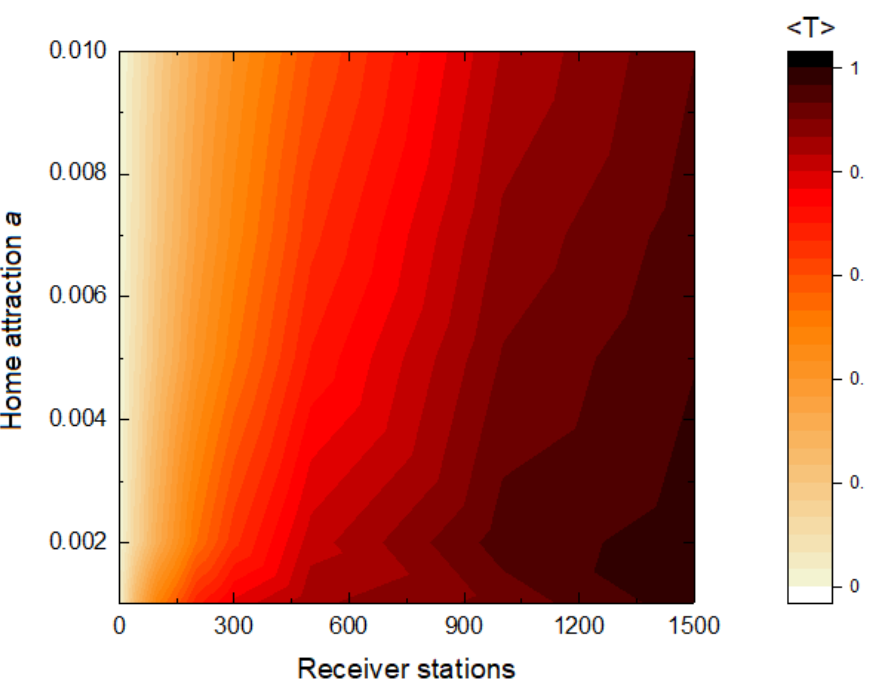
Figure 4. Average number of transmitted packages (cid:104) T (cid:105) per unit of time and animal as a function of the home attraction a and the number of receiver stations. Other parameter values: r = 0.01, N = 500 and v = 0.001. 20,000 time steps were